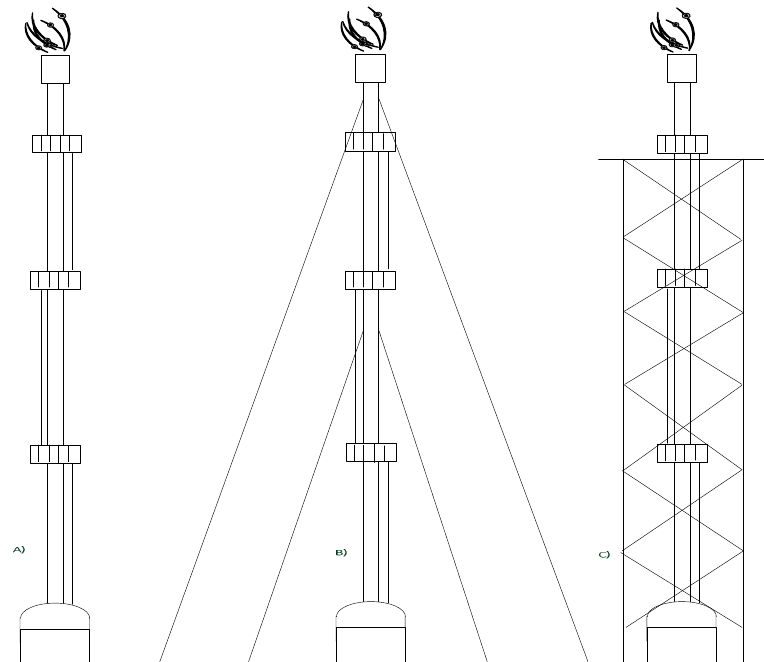
Figure 1. Division of flares in view of their construction: ( A ) self-supporting flare, ( B ) flare with guy-ropes, and ( C ) flare with a lattice